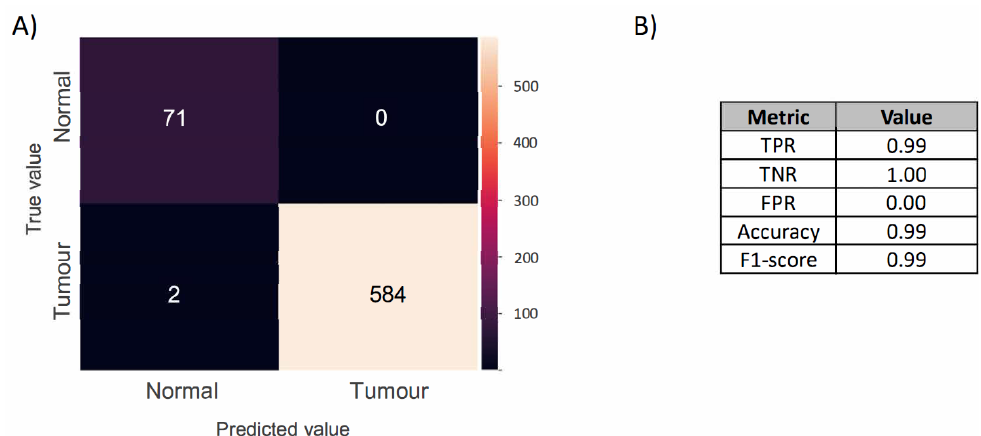
Figure 6. ( A ) Confusion matrix of the MSI-based LR classification model produced by the cross- validating normal and cancerous FFPE samples, comparing the predicted label ( x -axis) with the true label ( y -axis), with true positives appearing along the matrix diagonal. ( B ) Model performance. The table reports the true positive rate (TPR), true negative rate (TNR), false positive rate (FPR), accuracy, and